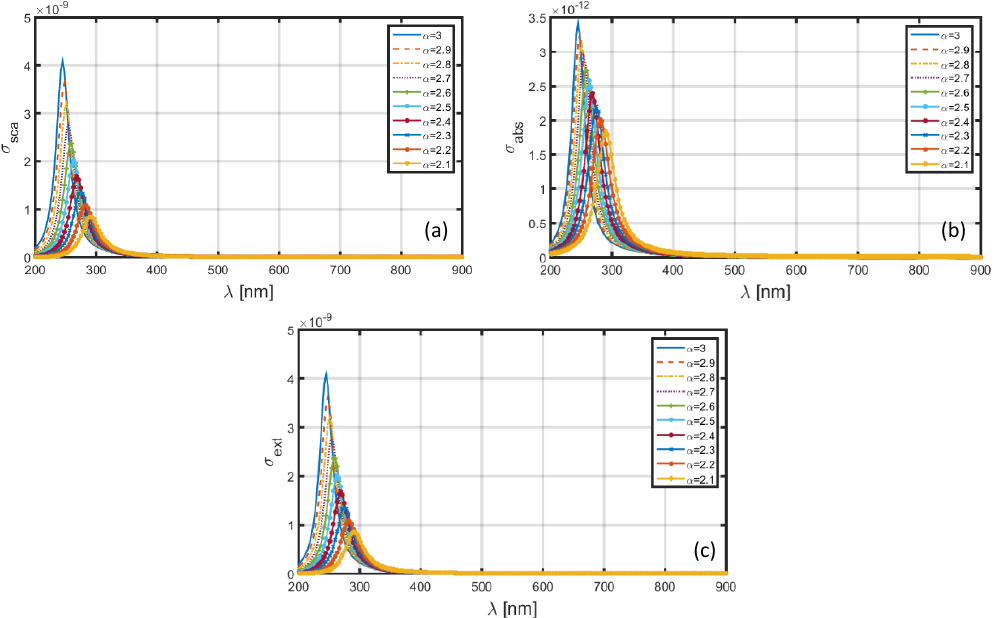
Figure 7. Plots of ( a ) scattering cross-section, ( b ) absorption cross-section, and ( c ) extinction coe ffi cient against λ for SiO 2 -Al nanoparticle in the FD space corresponding to the dimensions a = 60 nm, b = 80 nm.